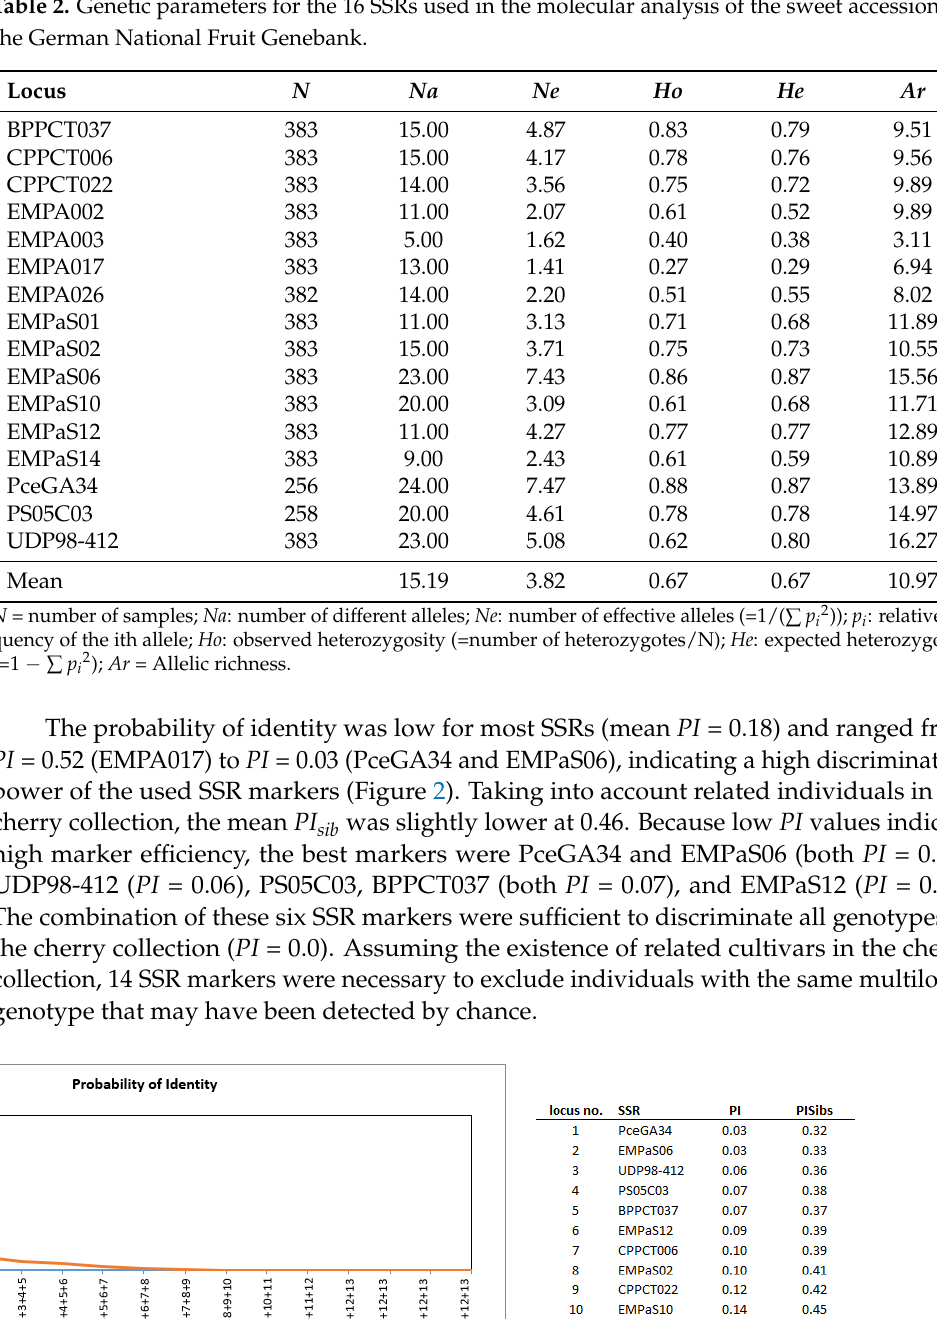
Table 2. Genetic parameters for the 16 SSRs used in the molecular analysis of the sweet accessions of the German National Fruit Genebank. Locus N Na Ne Ho He BPPCT037 383 15.00 CPPCT006 383